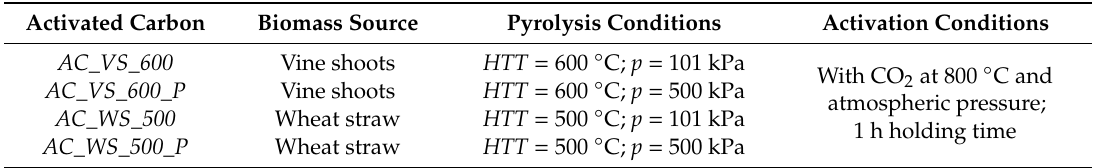
Table 1. Summary of the preparation procedure for the physically activated carbons (ACs) tested in the present